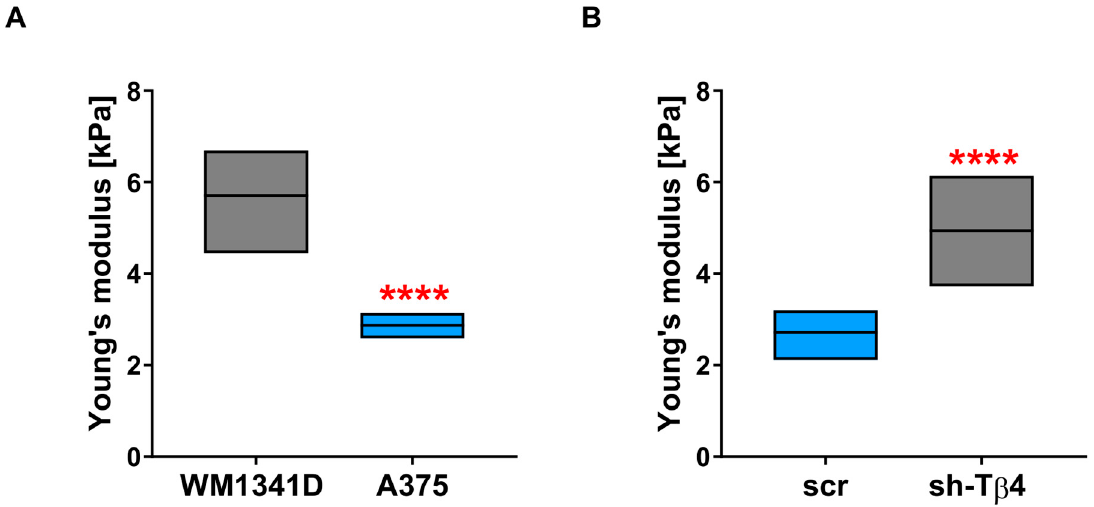
Figure 8. Analysis of the role of T β 4 in the mechanical properties of melanoma cells. Single-cell force spectroscopy (SCFS) measurements were performed to calculate Young’s modulus for tested melanoma cells. For every cell, five curves were acquired. The average values of Young’s modulus are presented in the graphs: ( A ) for WM1341D and A375 cells ( n = 30) and ( B ) for scr ( n = 30) and sh-T β 4 clones ( n = 30 for every clone). The significance level was set at **** p < 0.0001. Graphs indicate average-max-min values. The results presented separately for every clone are shown in Supplementary Figure S16.